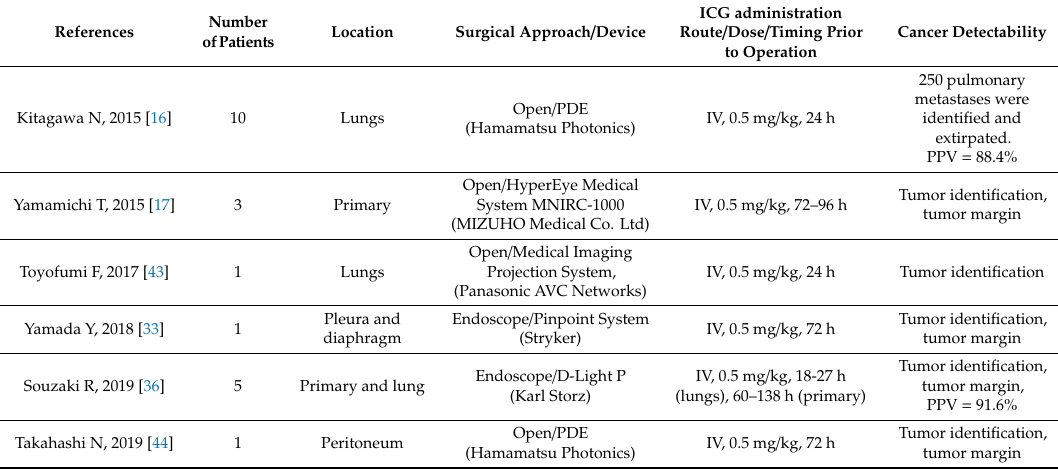
Table 4. Previous reports on indocyanine green (ICG)-fluorescence-guided navigation for HB. PPV: positive predictive